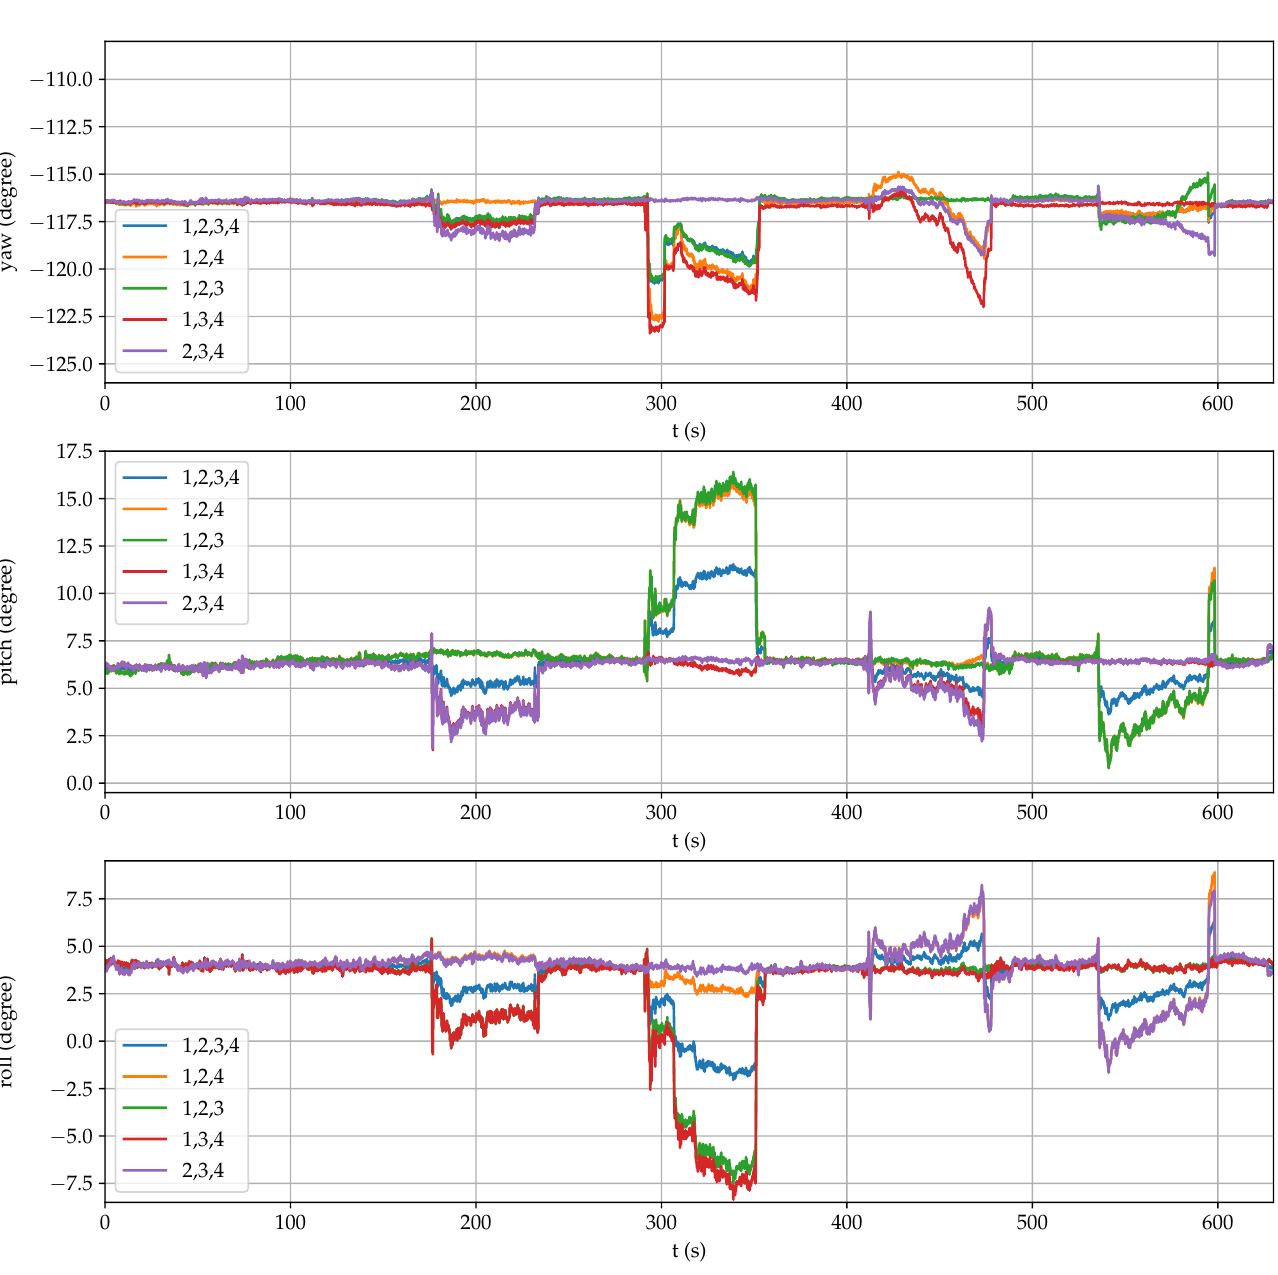
Figure 9. Estimation of posture coordinates during the reliability